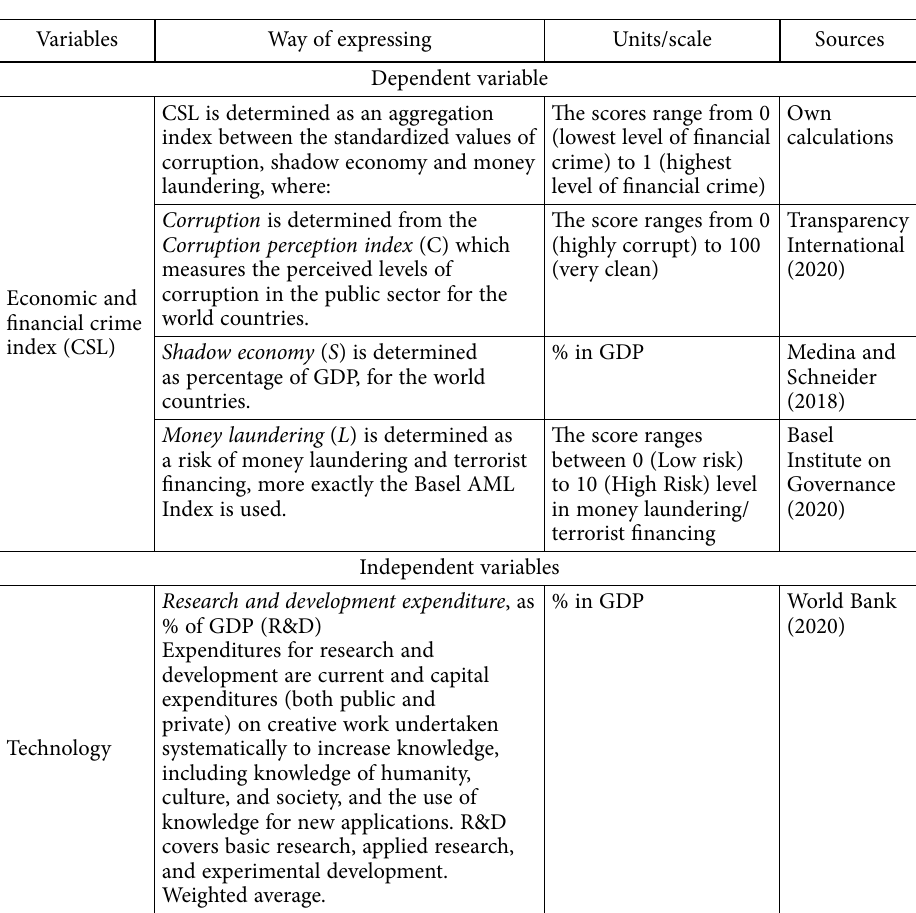
Table 1.Variables and